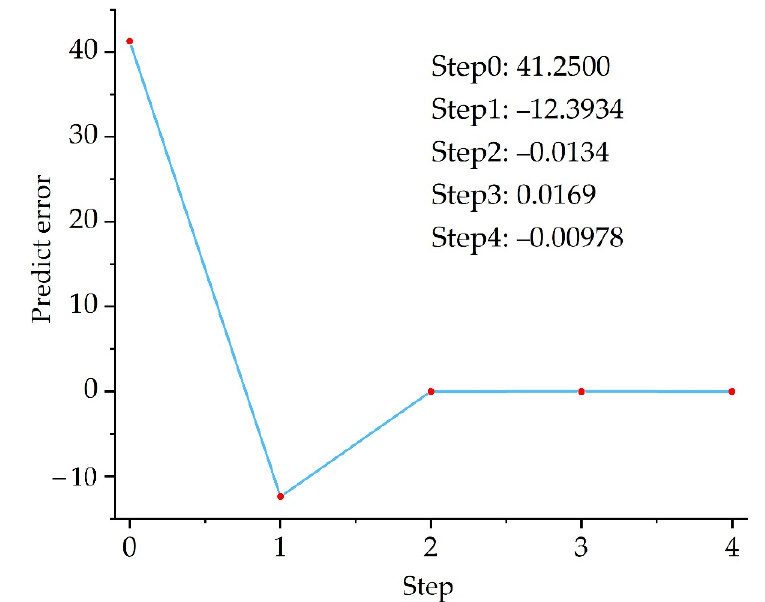
Figure 8. Absolute errors of the predict values of optimal design points.